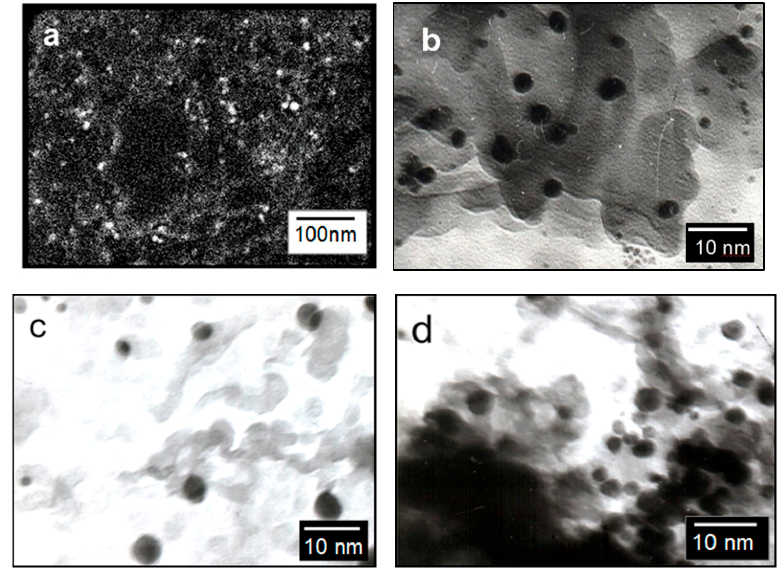
Figure 4. Electron microscopy (EM) images of Rh-Pt(9:1)/ γ -Al 2 O 3 . (a) SEM. (b–d) TEM (an increase of